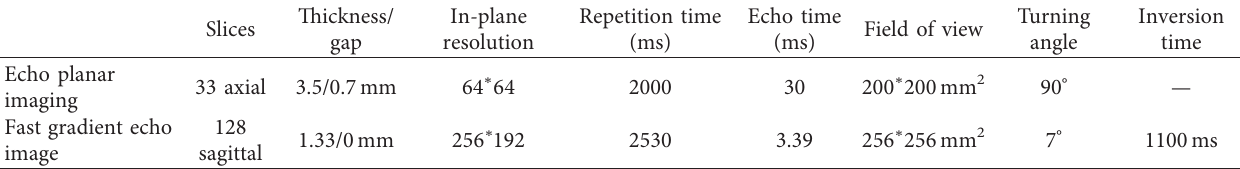
Table 1: Relevant information of echo planar imaging and fast gradient echo